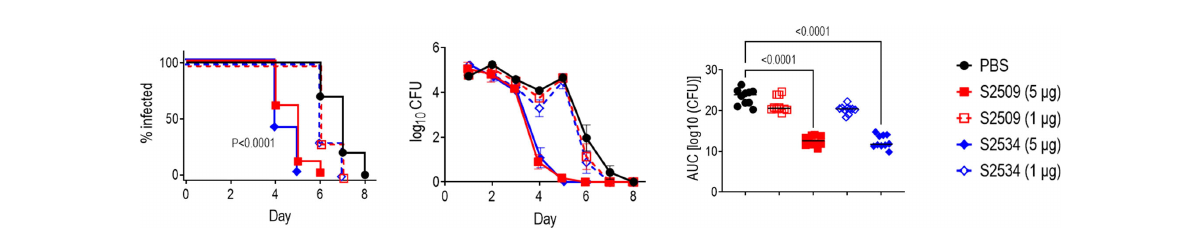
FIGURE 8 Ef fi cacy of S2509 (Fc1/FH*) and S2534 (Fc3/FH*) against N. gonorrhoeae FA1090 in human FH/C4BP transgenic mice. Estrogen pellet-treated 6 week-old human FH/C4BP transgenic mice (n=10/group) were infected with 2.4 x 10 7 CFU N. gonorrhoeae strain FA1090. Mice were treated daily (starting 2 h before infection) intravaginally either with PBS (vehicle control) or with 1 or 5 µg of each fusion protein. Left graph : Kaplan Meier curves showing time to clearance, analyzed the Mantel-Cox (log-rank) test. Both treatment groups that received 5 µg/d showed signi fi cantly faster clearance (P < 0.0001) compared to each of the other groups when compared in a pairwise manner. Middle graph : log 10 CFU versus time. X-axis, day; Y-axis, log 10 CFU. Comparisons of the CFU over time between each treatment group and the respective saline control was made by two-way ANOVA and Dunnett ’ s multiple comparison test. The two groups that received 5 µg of the fusion protein daily showed signi fi cantly lower CFUs compared to the PBS groups on days 4, 5 and 6 (P < 0.0001, P < 0.0001 and P < 0.05, respectively). Right graph : Bacterial burdens consolidated over time (Area Under the Curve [log 10 CFU] analysis). The fi ve groups were compared by one-way ANOVA using the non-parametric Kruskal-Wallis equality of populations rank test. The c 2 with ties was 39.11 (P < 0.0001). Pairwise AUC comparisons across groups was made with Dunn ’ s multiple comparison test.